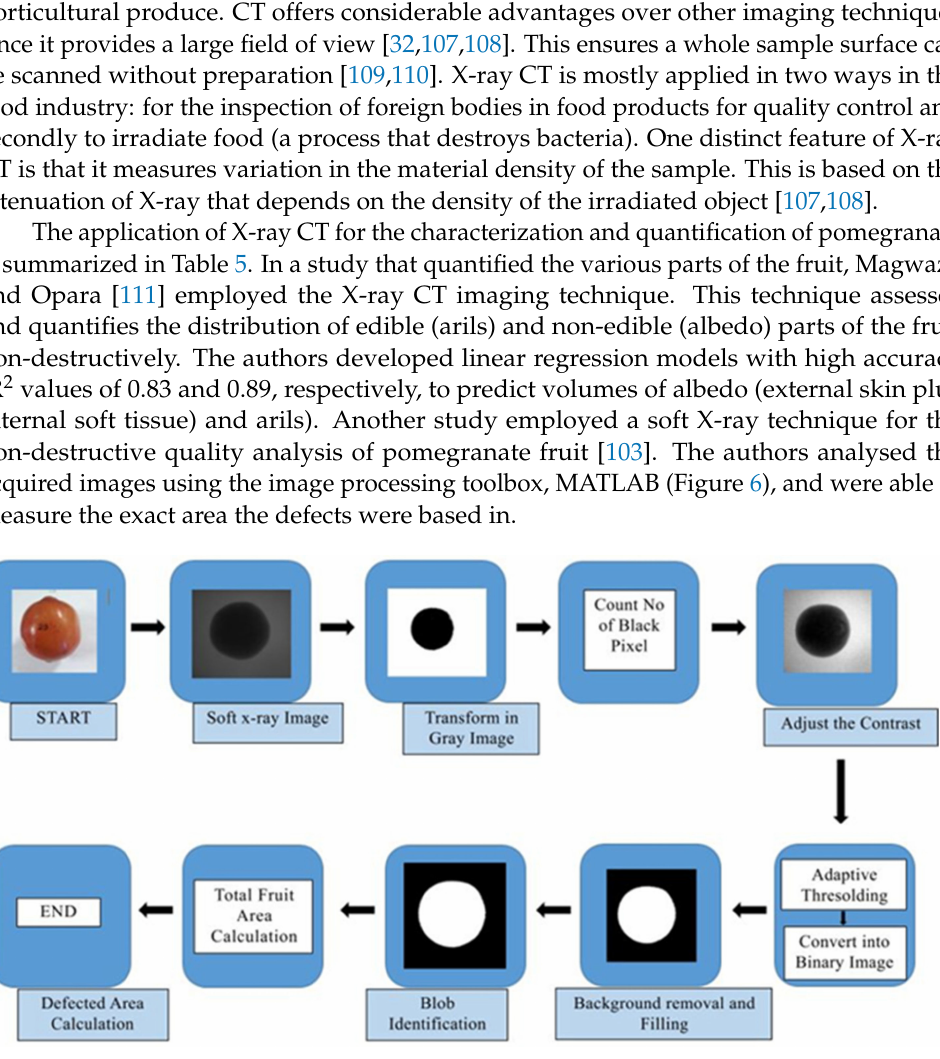
Figure 6. The image processing and the defect identification algorithm flowchart for soft X-ray application in detection of defect in pomegranate fruit. Adapted from